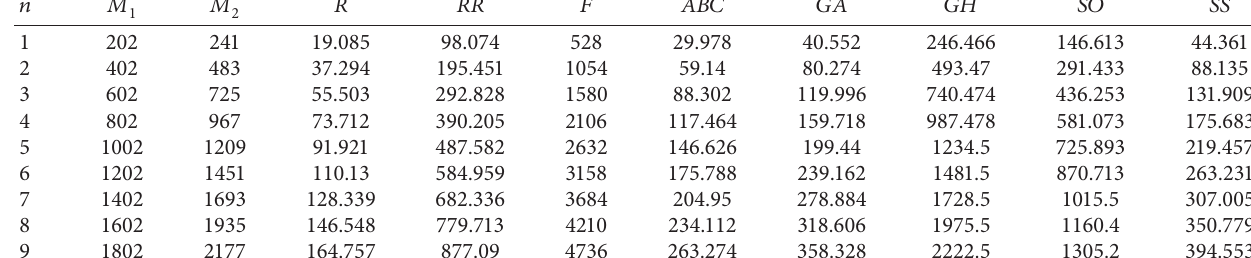
Table 6: Numerical representation of the computed indices for CMHPG.